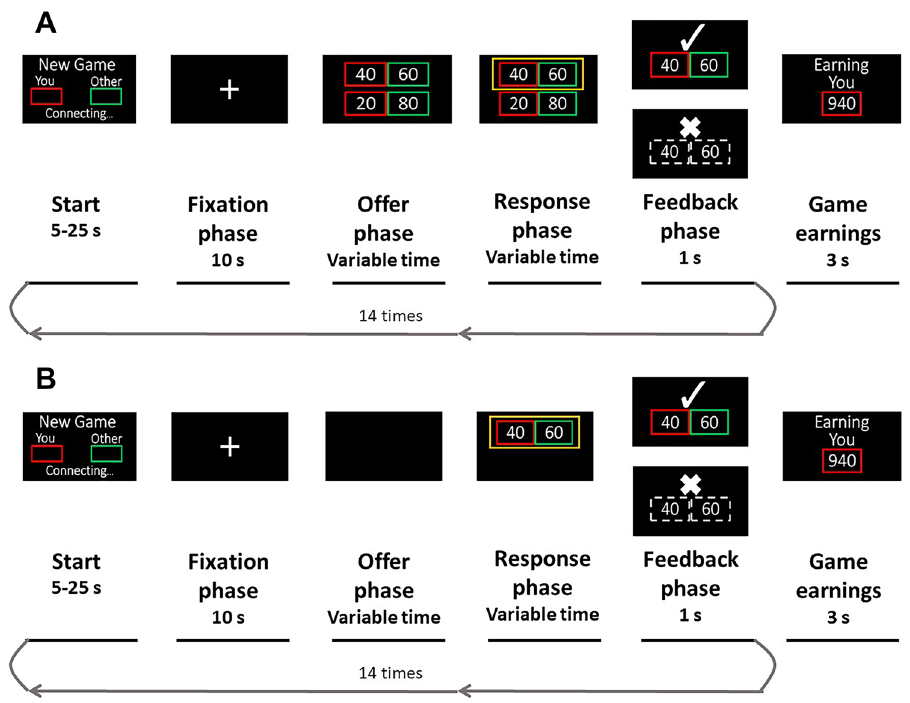
Figure 1. Timeline for the UG. The green box is for the proposer and the red box is for the participants’ role as responders. The trial started by looking at the fixation cross; then, during comparative condition ( A ), participants could see the proposer’s options before their final offer (surrounded by a yellow box). During individual condition ( B ), participants just could see the final offer. After, responders decided if they would accept and split points or decline and discard points. At the end of each round, the total points earned